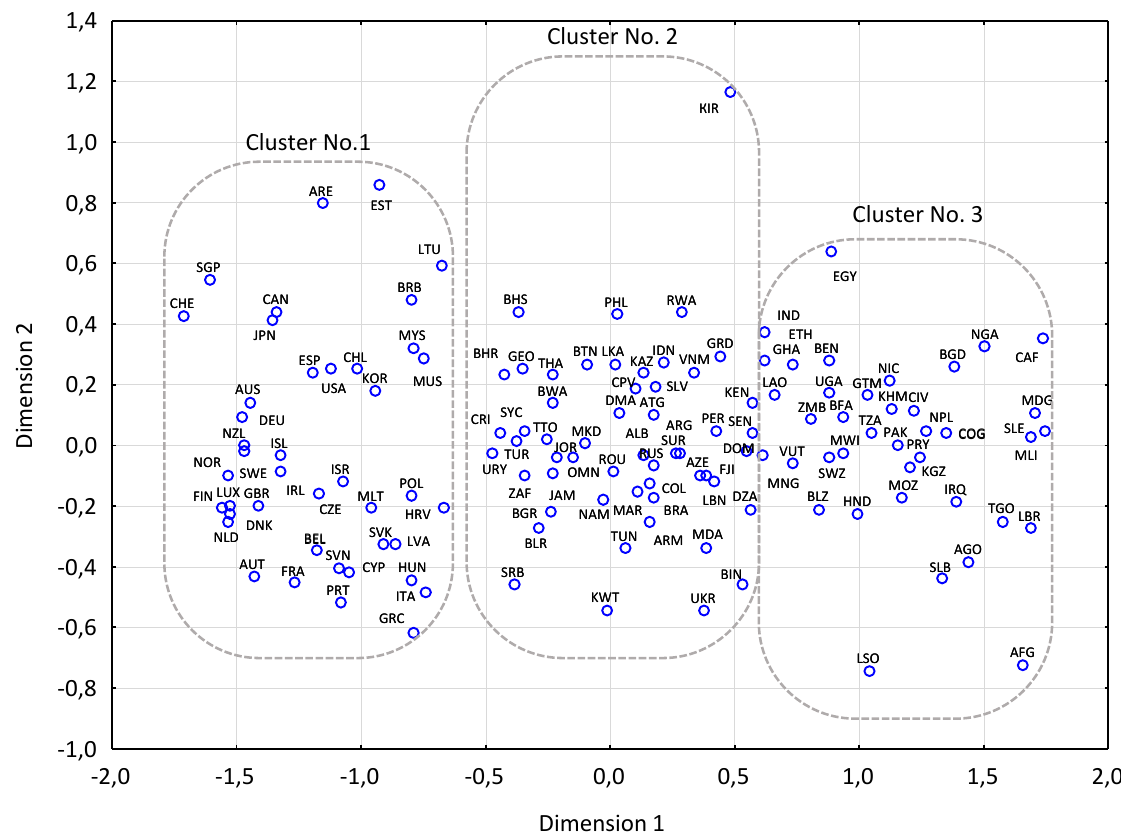
Figure 1. Ordination of countries according to their multidimensional scaling according to EPI, GEI and ExpGov